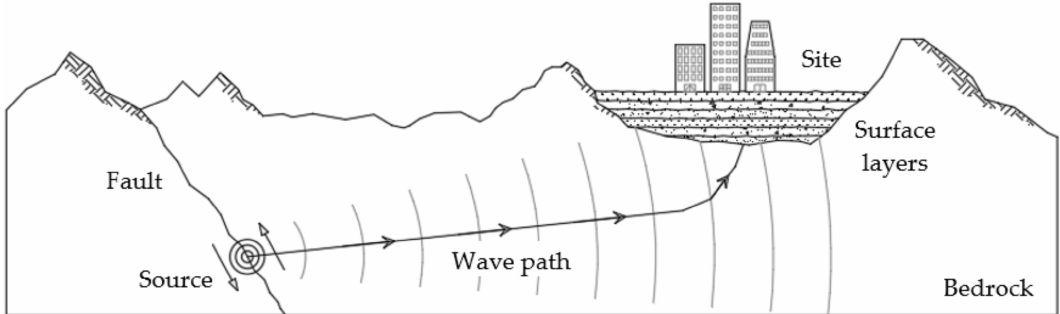
Figure 8. Path of vibrational waves from the seismic source to the surface layers.